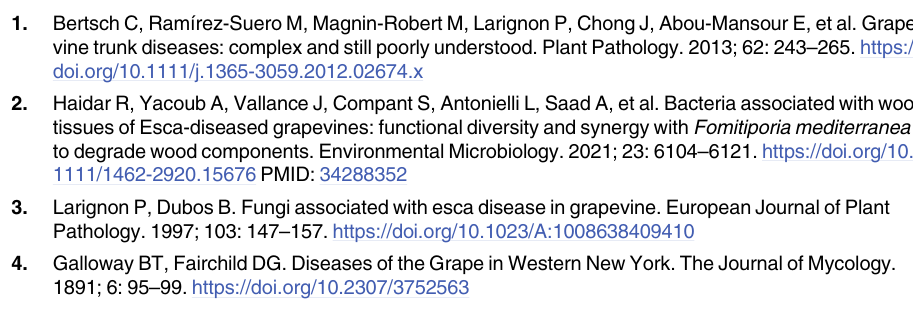
S1 Fig. Mosaic plot of genus level taxa isolated from sample varieties. (TIF) S2 Fig. Mosaic plot of genus level taxa isolated from sample variety berry color. (TIF) S3 Fig. Mosaic plot of genus level taxa isolated from sample section types. (TIF) S4 Fig. Mosaic plot of genus level taxa isolated from counties.